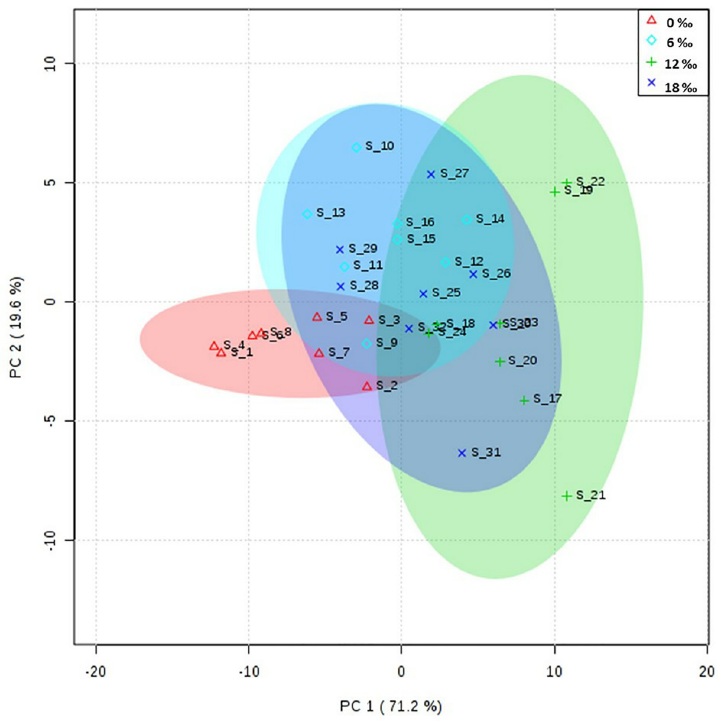
Fig 4. PCA scores plot of fatty acids profiles in the hepatopancreas of adult female E . sinensis .